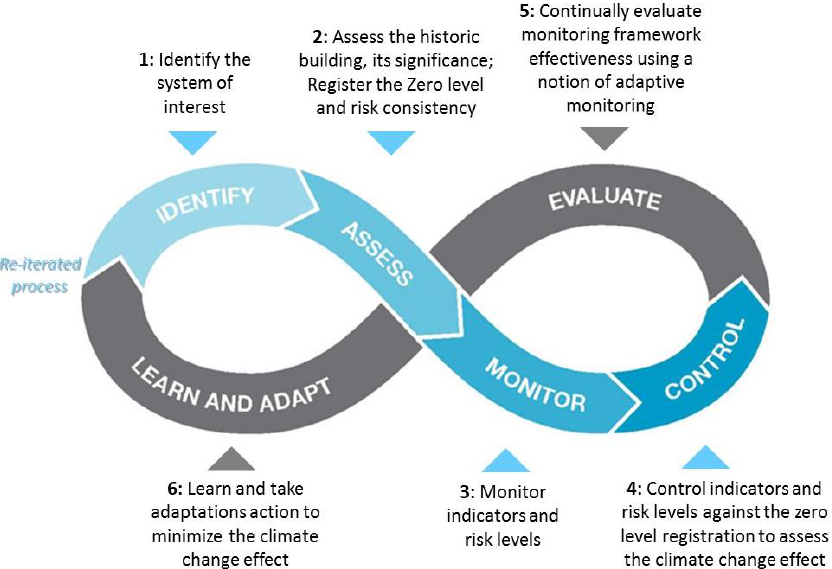
Figure 9. Through a closer connection between monitoring and adaptation, the risk assessment and preservation of cultural heritage values will improve.